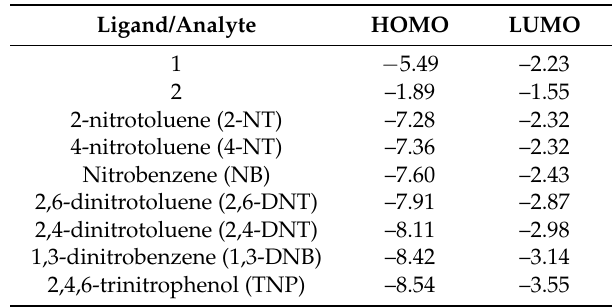
Table 1. The HOMO–LUMO energies (in eV) for different analytes and